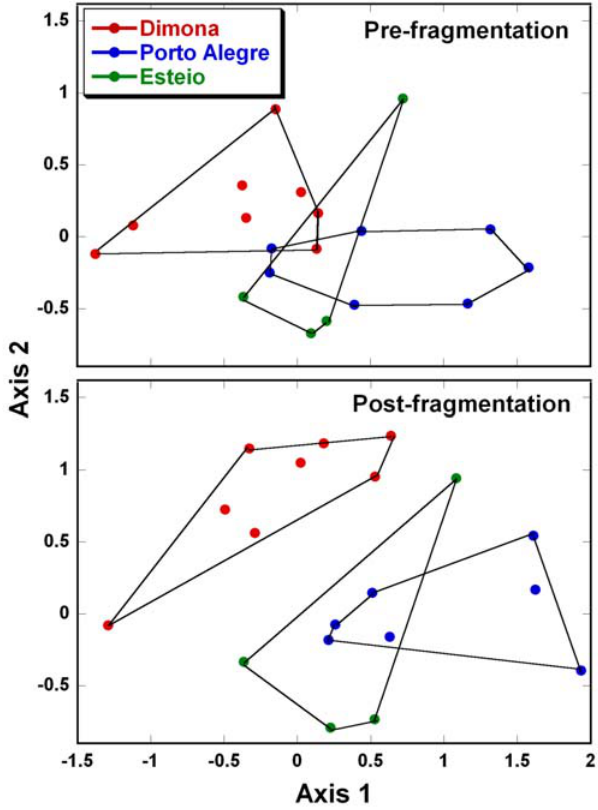
Figure 5. Increasing divergence of tree-community composition in three fragmented landscapes. Tree communities in forest-edge plots ( , 100 m from the nearest edge) are shown before forest fragmentation and 13–18 years after fragmentation, based on a single ordination of all plots and censuses in the study area. The ordination used importance values for all 267 tree genera found in the plots.